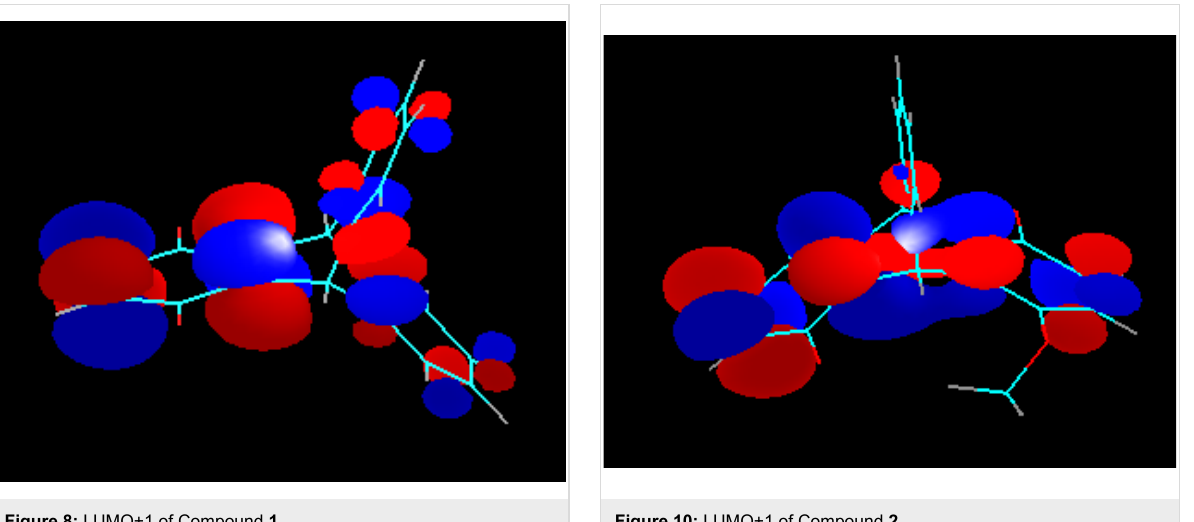
Figure 8: LUMO+1 of Compound 1 .